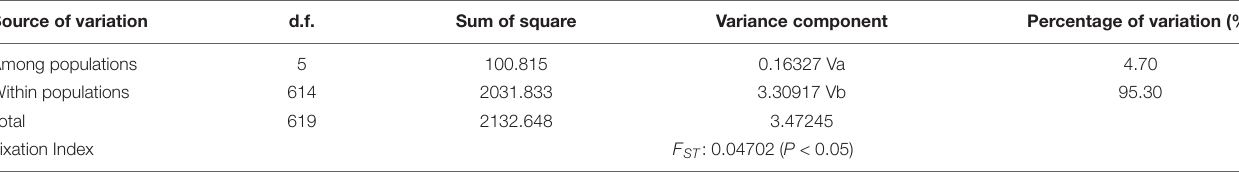
TABLE 4 | Analysis of molecular variance among six populations of rainbow clam.